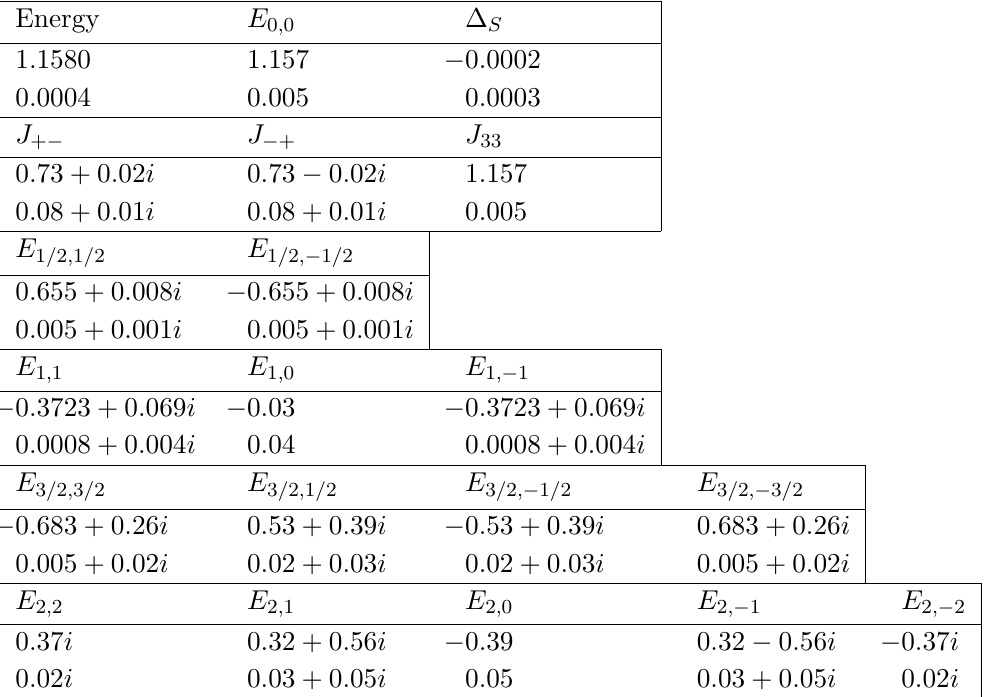
Table 23 . Selected observables of exotic solution number 4669 in the k = 8 model with J = 3 boundary conditions. We omitted data from levels 2 and 3 because the solution is complex at these levels.